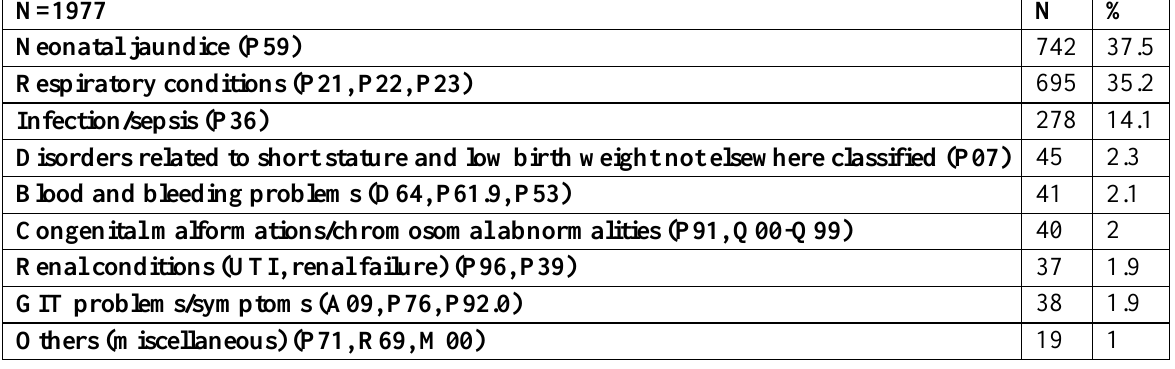
Table2 : Relative frequency for selected categories of cause of admission.